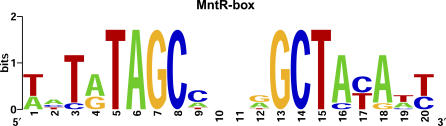
Sequence Logos for the Predicted MntR Recognition Motifs in α-Proteobacteria